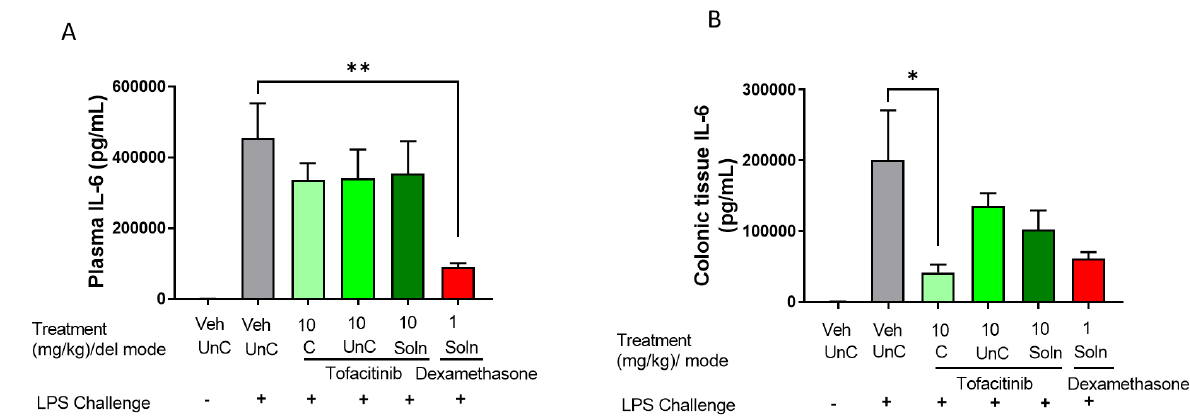
Figure 6. Plasma ( A ) and colonic tissue ( B ) concentrations of interleukin 6 (IL-6) in rats with LPS- induced inflammation 8 h after administration of ileocolonic-targeted (coated capsule, C), and un- targeted (uncoated capsule, UnC) tofacitinib capsules or 4 h after tofacitinib solution (Soln). Controls included naïve rats (no LPS, treatment with phosphate buffered saline (PBS)); LPS + vehicle (LPS administration, treatment with PBS); and LPS + 1 mg/kg dexamethasone solution. n = 8 for each treatment group.